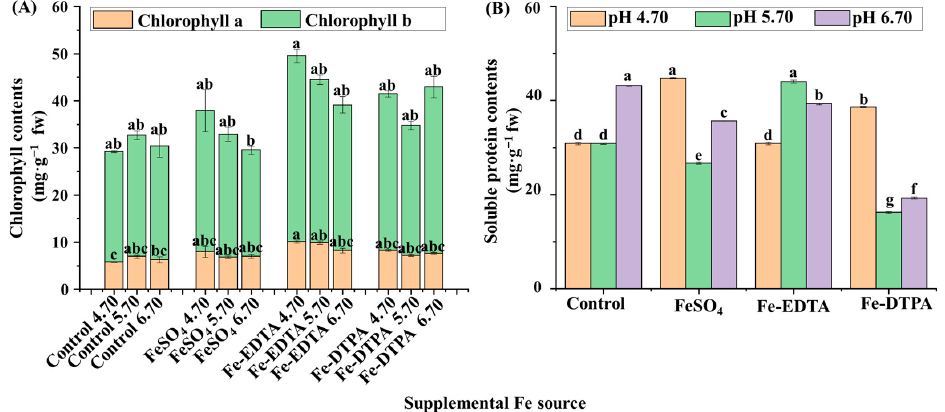
Figure 2. The contents of chlorophyll ( A ) and soluble proteins ( B ) in S. commixta after 6 weeks of culture; fw, fresh weight. Lowercase letters indicate significant differences by the Duncan’s multiple range test at p ≤ 0.05.